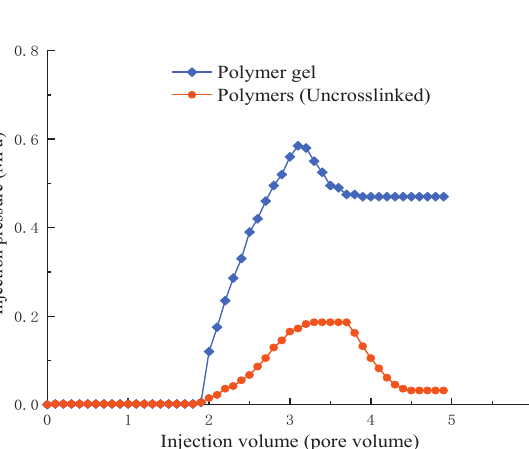
Figure 2: SEM images of polymer gel microstructure.